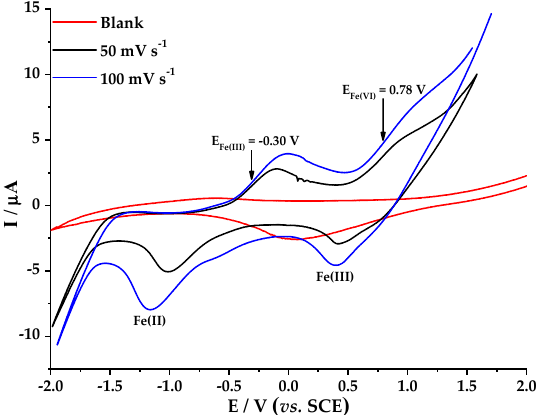
Figure 3. Behavior of 6 mM FeSO 4 at different voltammetric scan rate, 0.05 M Na 2 SO 4 , on BDD 0.5 cm 2 as working electrode; counter electrode—platinum wire.